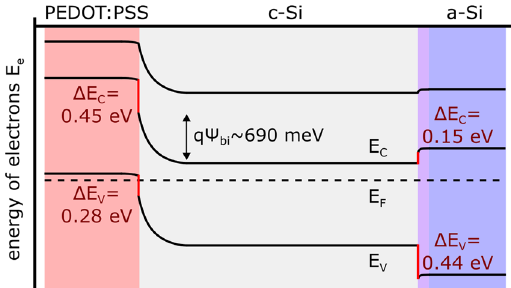
is obtained by C - V measurements. bi